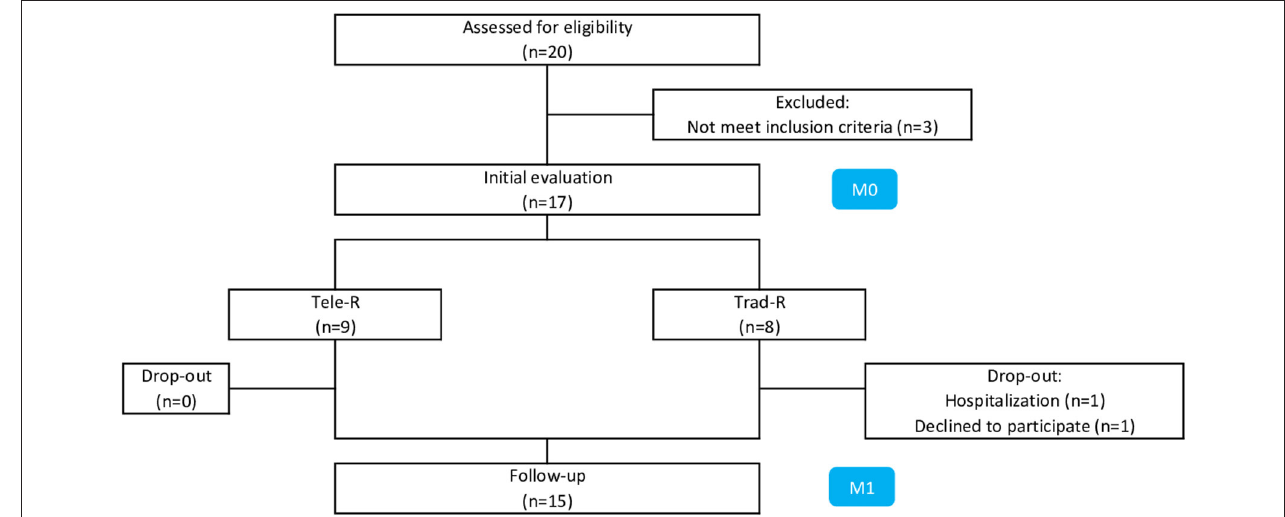
FIGURE 5 | Flowchart. Tele-R, telerehabilitation group; Trad-R, traditional rehabilitation group.